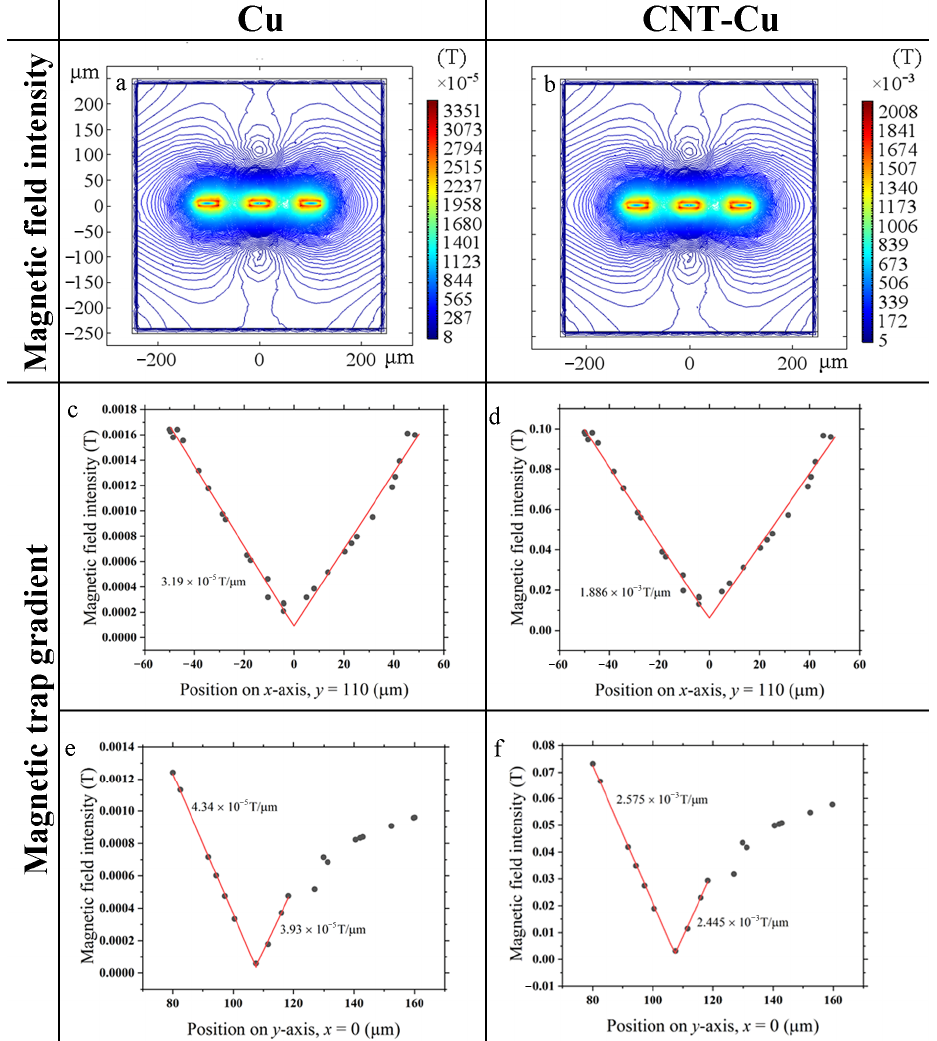
Figure 7. The calculation results of the magnetic trap produced by Cu wires and CNT–Cu wires. The black dots are the finite element simulation results. The red lines are the fitting date to calculate the magnetic trap gradient. The magnetic trap is produced by Cu wires ( a ) and by CNT–Cu wires ( b ). ( c ), ( e ) is the data of the cutting line crossing the magnetic trap in ( a ) along the x-axis and y-axis, respectively, while ( d ), and ( f ) is for ( b ).